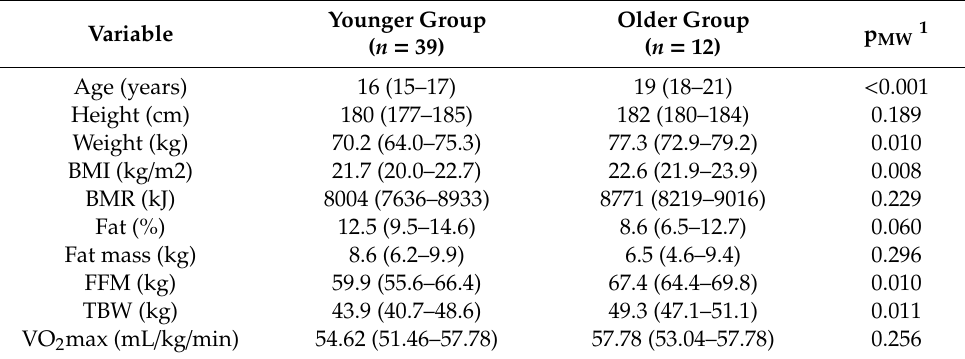
Table 1. Participants’ body composition variables and VO 2 max